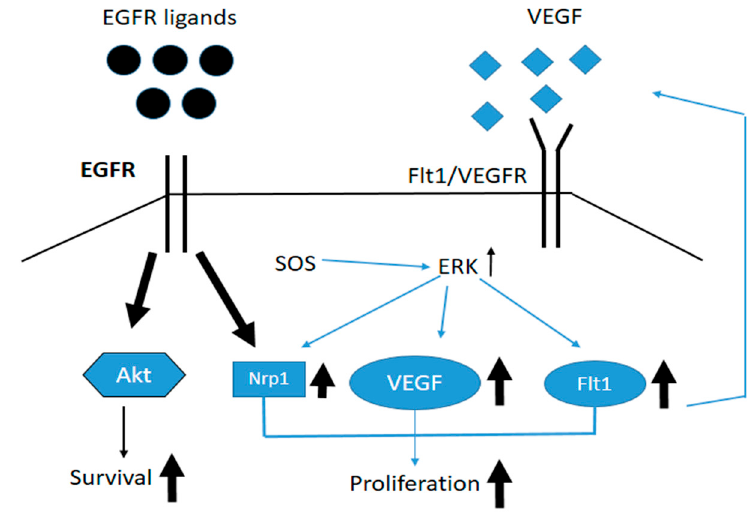
Scheme 1. Activation pathway of enzymes VEGFR and EGFR. In the above figure, SOS is representing the son of sevenless, which is an RAS-activating factor. Flt 1 is a VEGFR receptor as Flt1 is a gene encoding VEGFR receptor, ERK (Extracellular signal-regulated kinase), Nrp1 is a cell surface protein and Akt is a serine/threonine kinase. Activation mechanism is denoted by thick and thin arrows, whereas double vertical lines are representing EGFR receptor [12,13].